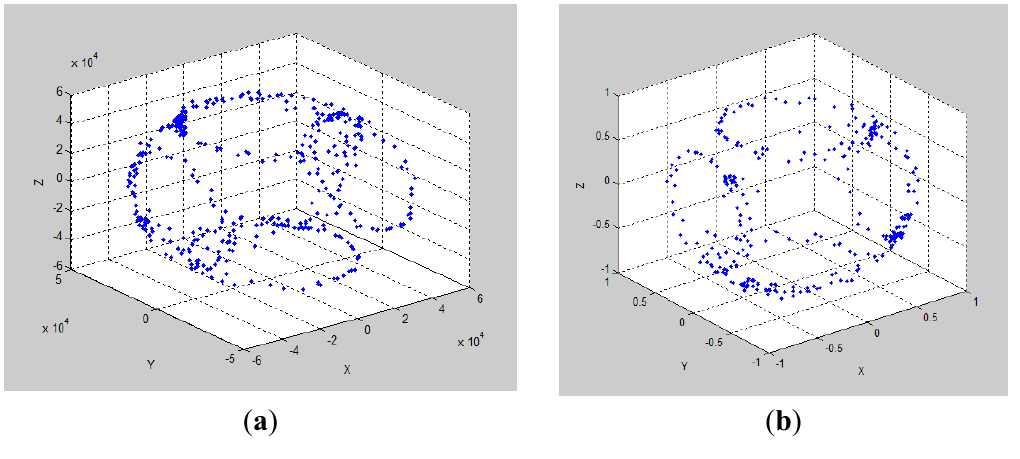
Figure 9. Comparision of fluxgate output data before and after